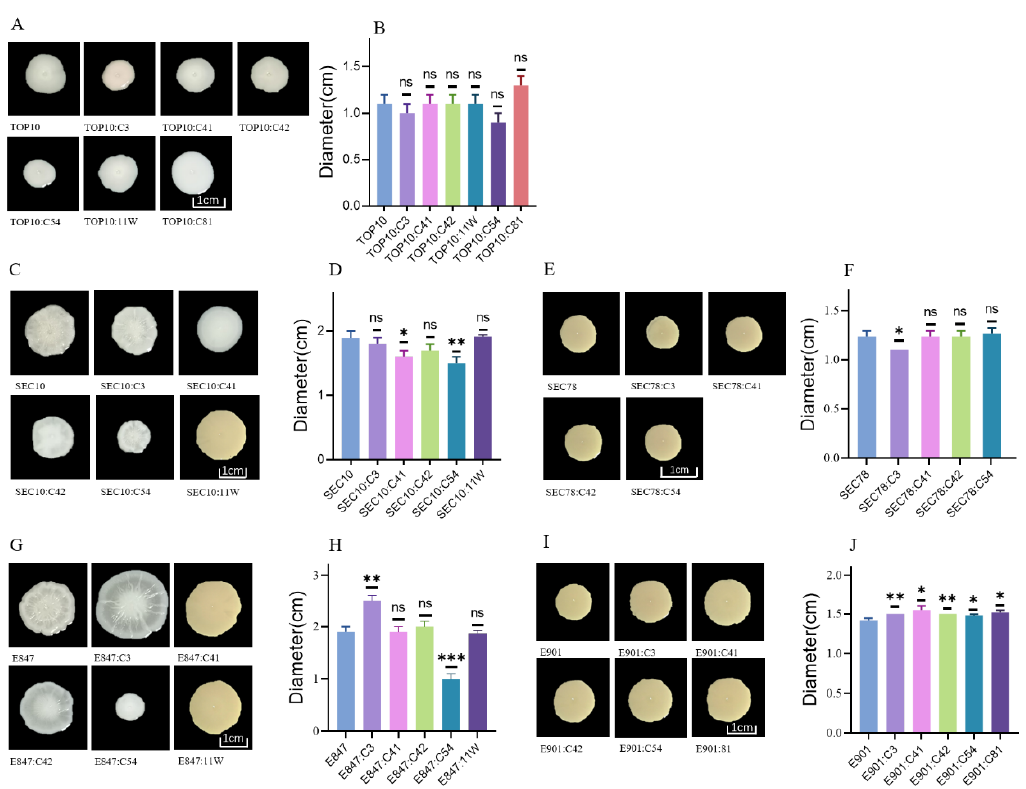
Figure 3. Swimming motility of the transformants and their corresponding isogenic plasmid-free strains. ( A ): Swimming motility of TOP10 and its transformants; ( B ): the mean diameters of TOP10 and its transformants; ( C ): swimming motility of SEC10 and its transformants; ( D ): the mean diameters of SEC10 and its transformants; ( E ): swimming motility of SEC78 and its transformants; ( F ): the mean diameters of SEC78 and its transformants; ( G ): swimming motility of E847and its transformants; ( H ): the mean diameters of E847 and its transformants; ( I ): swimming motility of E901 and its transformants; ( J ): the mean diameters of E901 and its transformants. Data are shown as mean ± SD. p -values were determined using the t -test (* p < 0.05, ** p < 0.01, *** p < 0.001, ns, not significant).